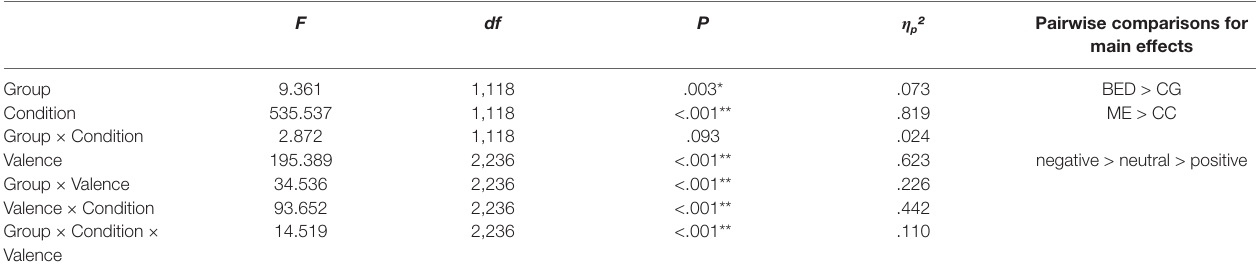
TABlE 4 | Statistics for the 3-way ANOVA concerning body-related cognitions.